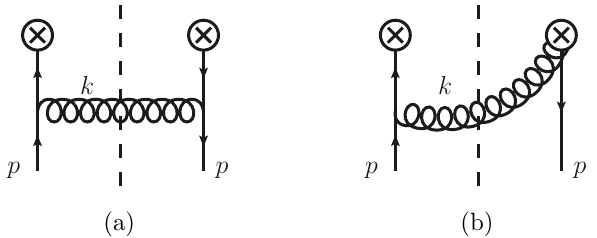
Figure 3. One-loop diagrams contributing to the spin-dependent beam function in eq. (2.5). Mirror diagrams and the scaleless wave function and tadpole diagrams are not shown. The dashed line indicates the on-shell constraint on the emitted gluon. The (cid:10) denotes the two Wilson line operators. Comparing to the decompositions in eqs. (2.9) and (2.19), we see that only the unpolarized ( f 1 and ~ f 1 ), helicity ( g 1 L and ~ g 1 L ) and transversity ( h 1 and ~ h 1 ) TMD and quasi-TMDs